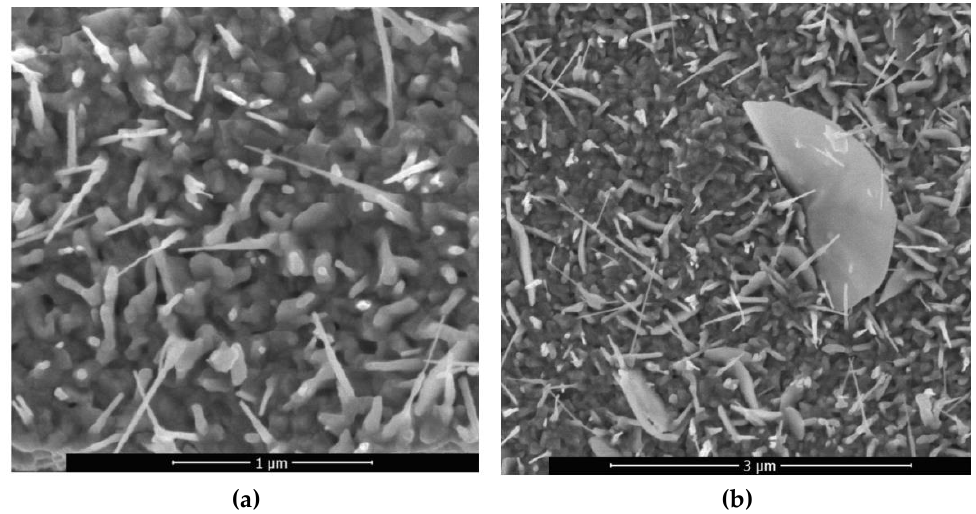
Figure 11. Scanning electron microscopy (SEM) image of ZnO nanowires ( a ), and ZnO structure consisting of nanowires and nanosheets ( b ) [151].